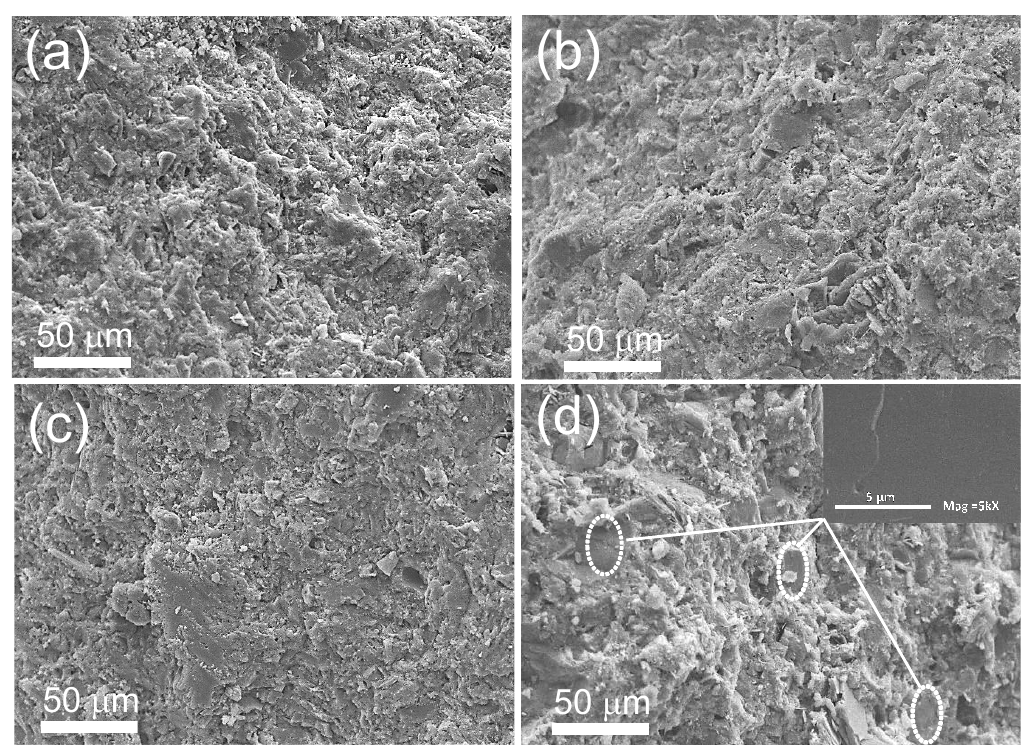
Figure 1. Bulk densities of the control PC and NL/PC1, NL/PC2, and NL/PC3 composites with NL/cement ratios of 5%, 10%, and 15%, respectively.